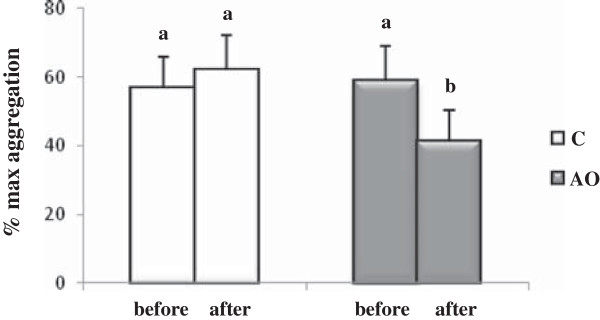
Platelet aggregation after 3 weeks of nutritional intervention with argan oil. Washed platelets were stimulated with thrombin (0.2 U/ml). Comparisons are made between the % platelet aggregation before and after the intervention period in the two groups. C: control group; AO: argan oil group. After a one-way ANOVA, Student-Newman-Keuls multiple comparison test, results are arranged in increasing order from left to right a > b (p < 0.05).